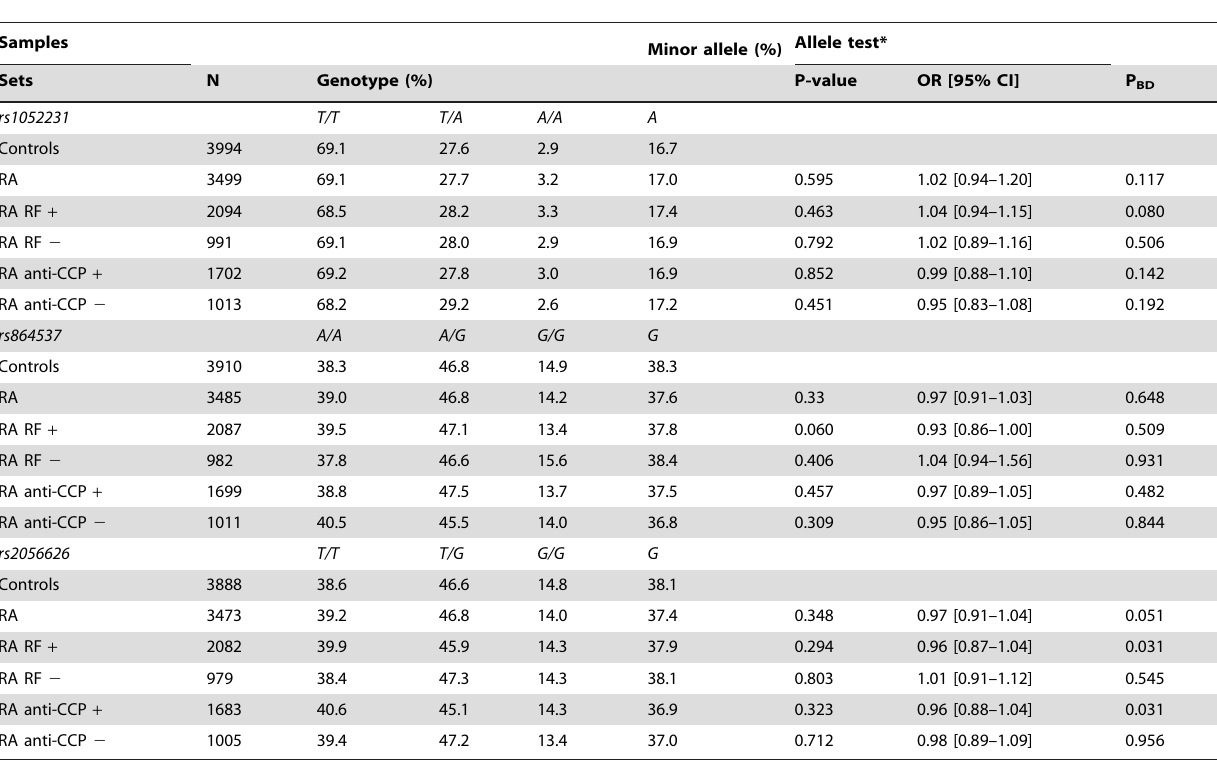
Table 1. Combined analysis of CD247 polymorphisms according to disease and serological